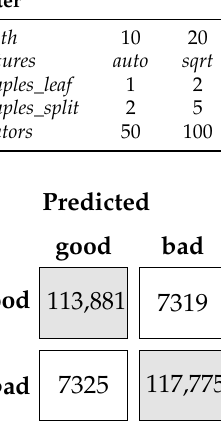
Figure A1. Confusion matrix of the CNN-FSQI cross-validation results. It shows the total number of predictions summed over all repetitions of the outer 10-fold